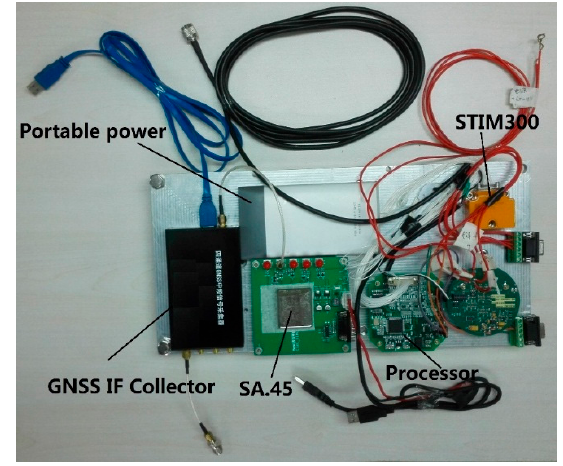
Figure 3. Photograph of the demo setup. Table 2. Main parameters of sensor in the setup.